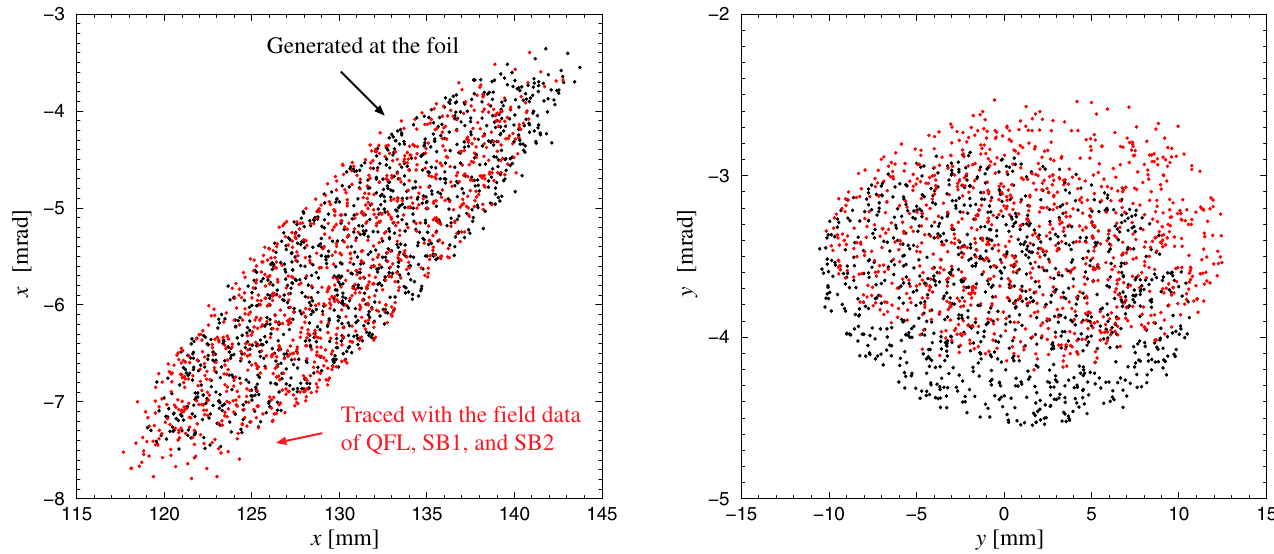
FIG. 9. (Color) Beam profile deformations on the incoming beam of (cid:2) 11 : 3 ; 8 : 9 (cid:3) (cid:1) mm mrad . The beam is located outside the good field region of QFL. Test particles were originally generated at the foil position ( s (cid:4) 82 : 113 m ) and traced back to the entrance of the shift- bump field area by transfer matrices assuming an ideal QFL. Particle tracking was carried out with the distributed field